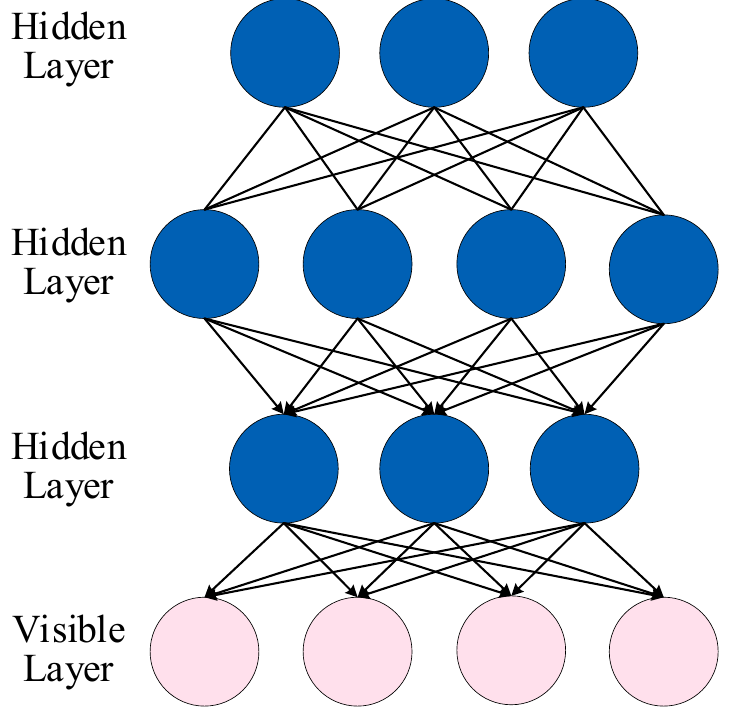
Figure 17. The structure of DBN.